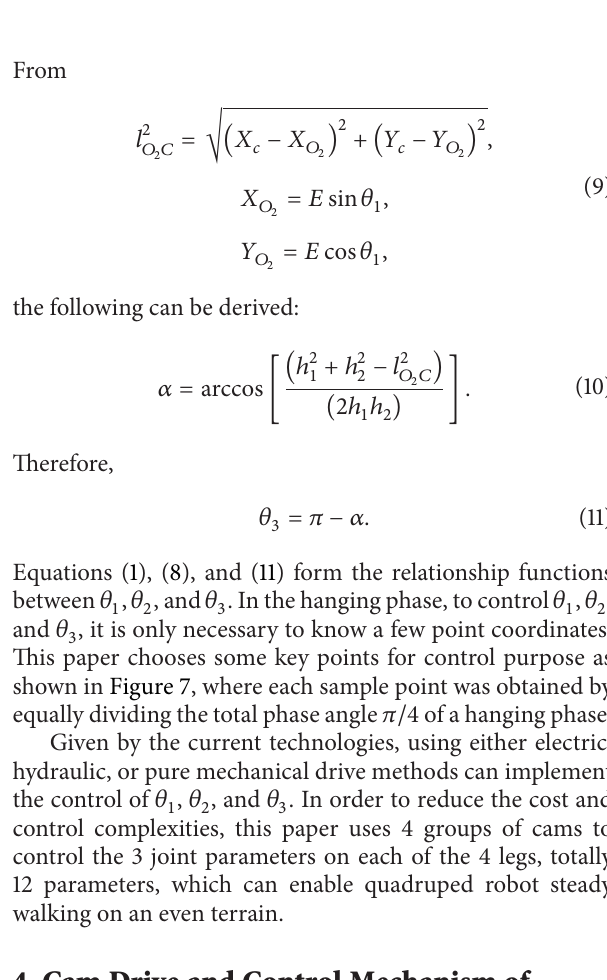
Figure 7: Key sample points chosen for cam